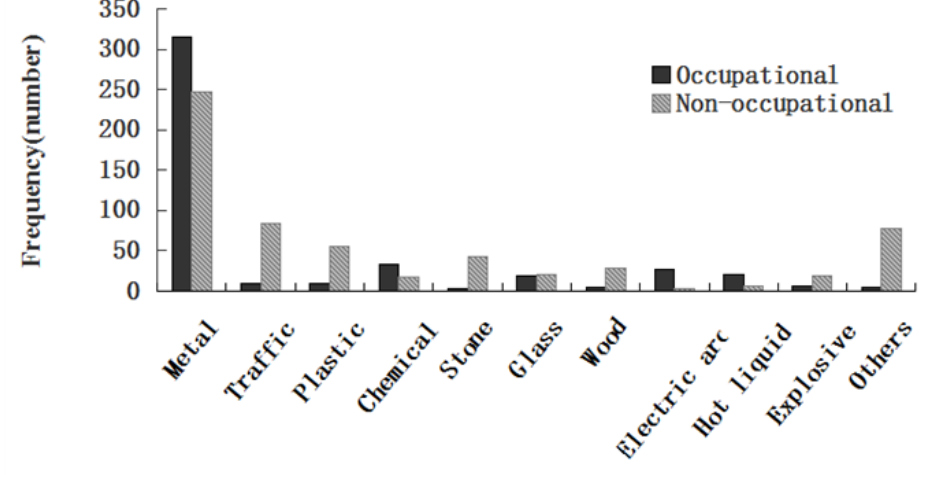
Figure 4. Causes of occupational and non-occupational eye trauma.